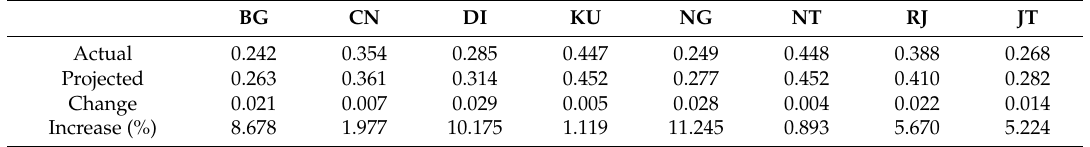
Table 13. Poverty rate in drought-prone districts on rainfall decrease.